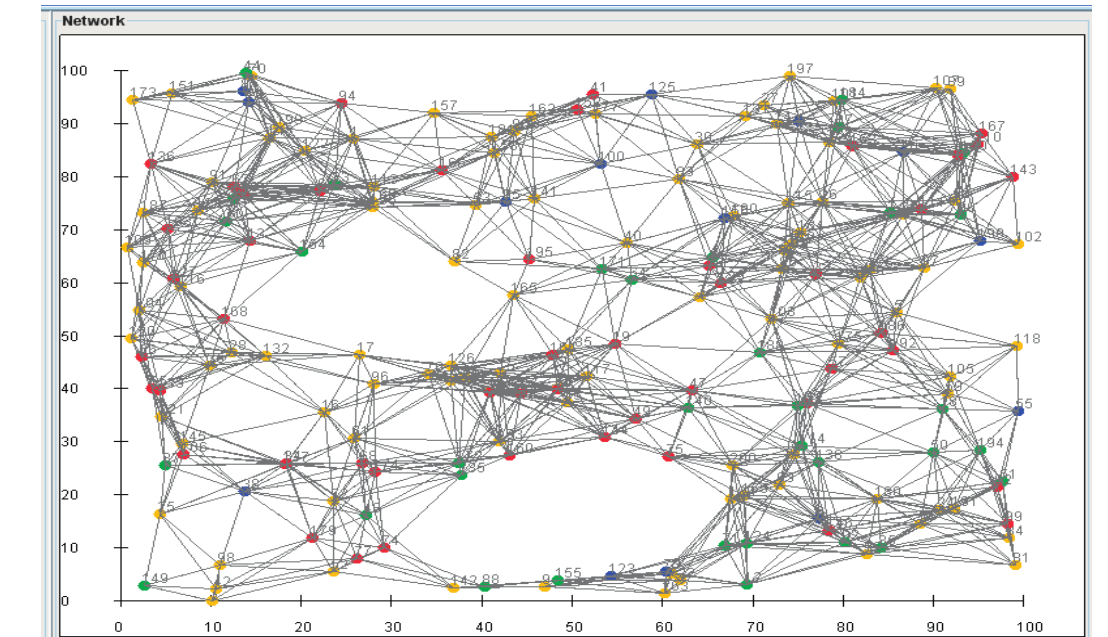
Figure 9. The interconnected sensor network.